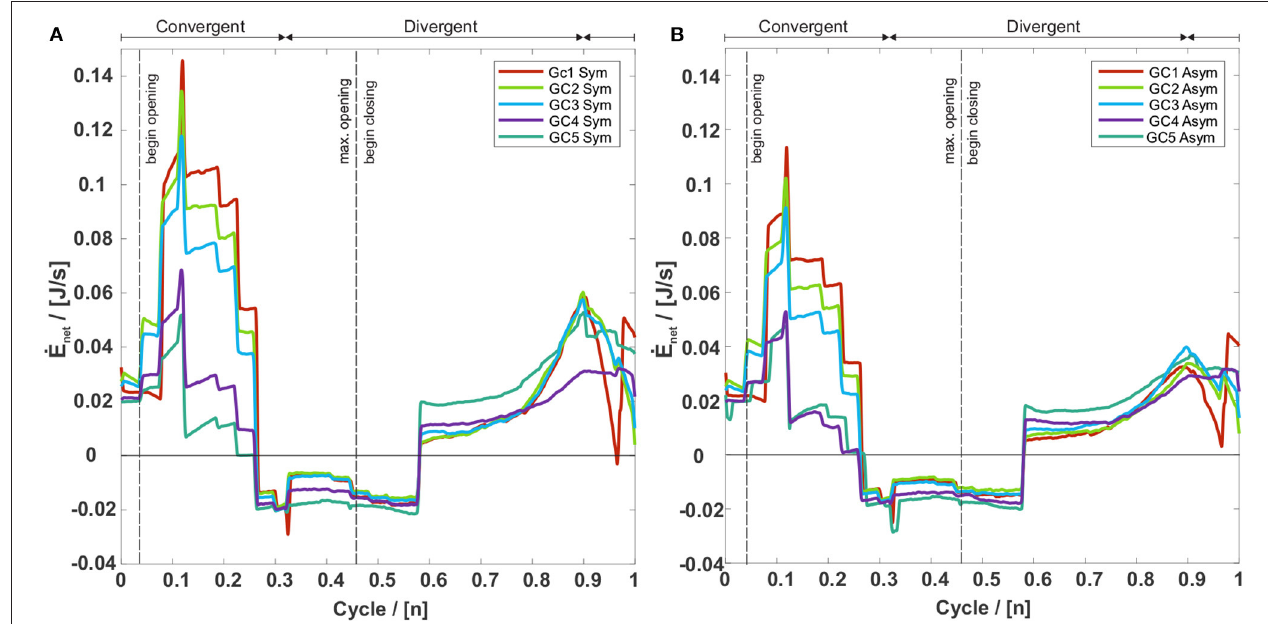
FIGURE 7 | Net rate energy transfer ( ˙ E net ) of the five GC types with (A) a symmetric and (B) an asymmetric vocal fold motion. A positive ˙ E net means an energy flux from the glottal flow toward the vocal folds and a negative ˙ E net an energy flux from the vocal folds toward the airflow. For both motion types ˙ E net is positive at the beginning and the end of the oscillation cycle. In these intervals ˙ E net decreases with an increasing glottal insufficiency, whereas the corresponding values of the asymmetric motion are collectively smaller than those of the symmetric motion.